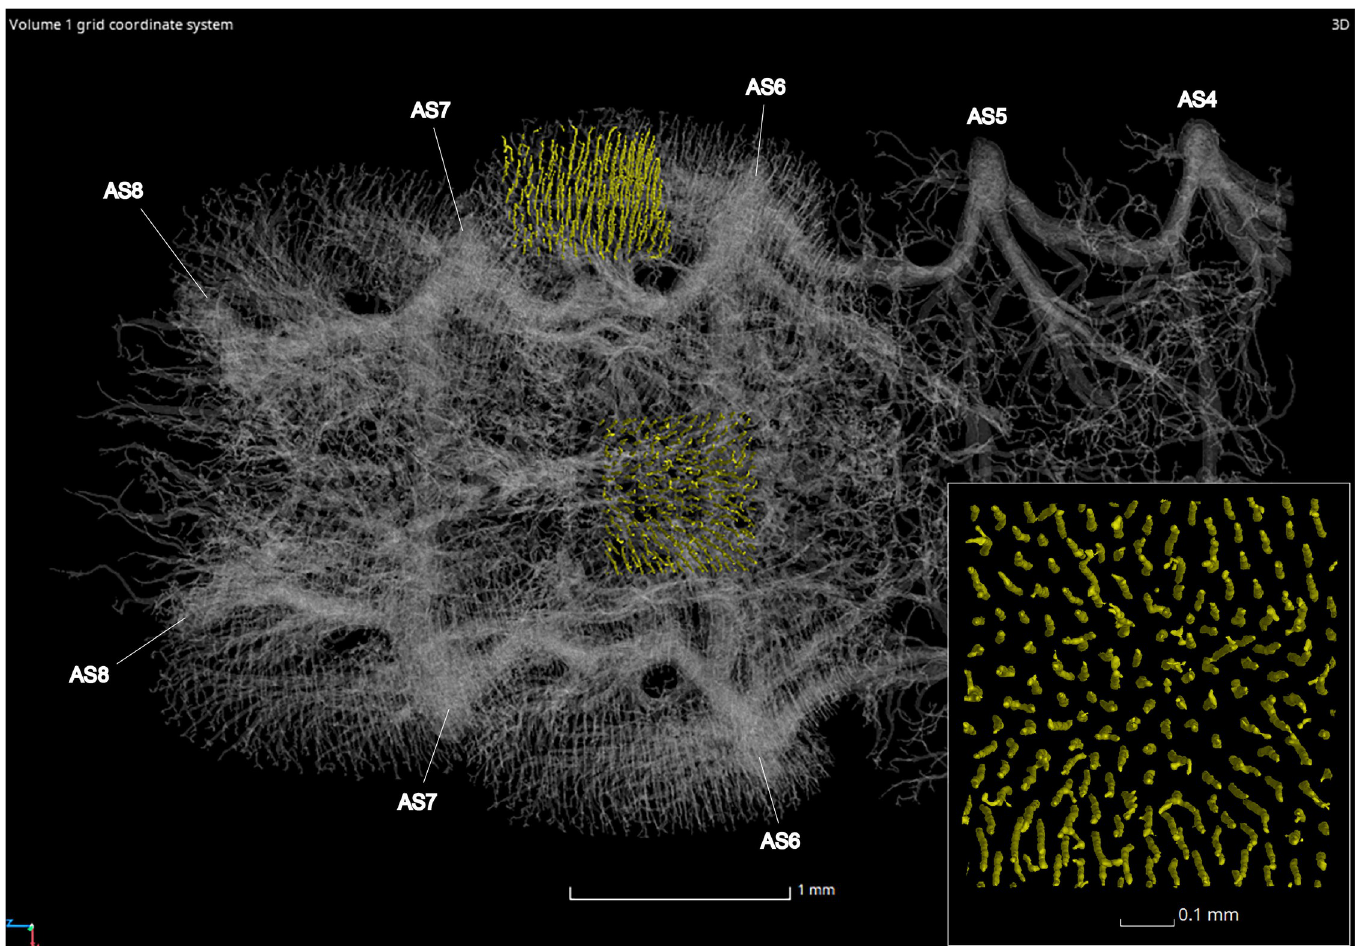
Fig 32. Ventral view of the adult male Photinus pyralis abdominal tracheal system showing segmentation of two 0.7mm 2 sections of the tracheal brush (highlighted in yellow) to assess tracheal density. Inset image highlights the organization of the tracheae penetrating the center of the light organ on abdominal segment VI.